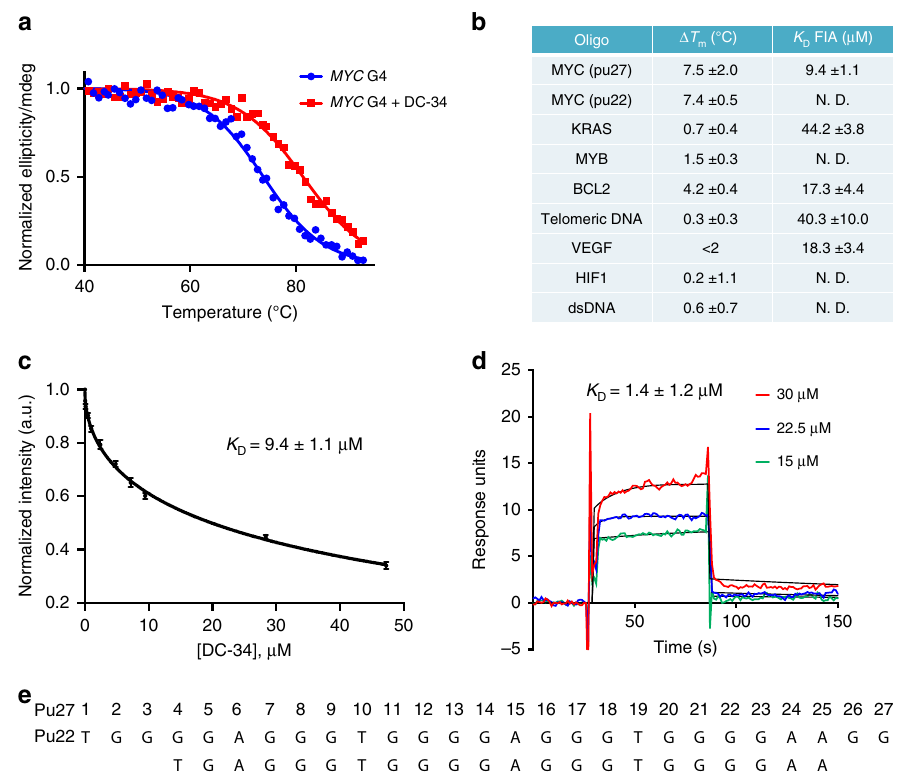
Fig. 2 Biophysical analysis of the DC-34/ MYC G4 interaction. a CD thermal melt of the MYC G4 Pu22 (10 µ M) in the absence (blue) and presence (red) of DC-34 (40 µ M). b Table of changes in thermal melting temperatures in the presence of four equivalents of DC-34 (measured by circular dichroism) and K D values of DC-34 against a panel of G4-forming sequences and dsDNA. c Fluorescence intensity curves of 5 titration of DC-34. K D = 9.4 ± 1.1 µ M. d Sensorgrams corresponding to 15 to 30 µ M injections of DC-34 over a 5 ′ biotin labeled MYC sensor chip. K D = 1.4 ± 1.2 µ M. e Sequence of MYC Pu 27 and